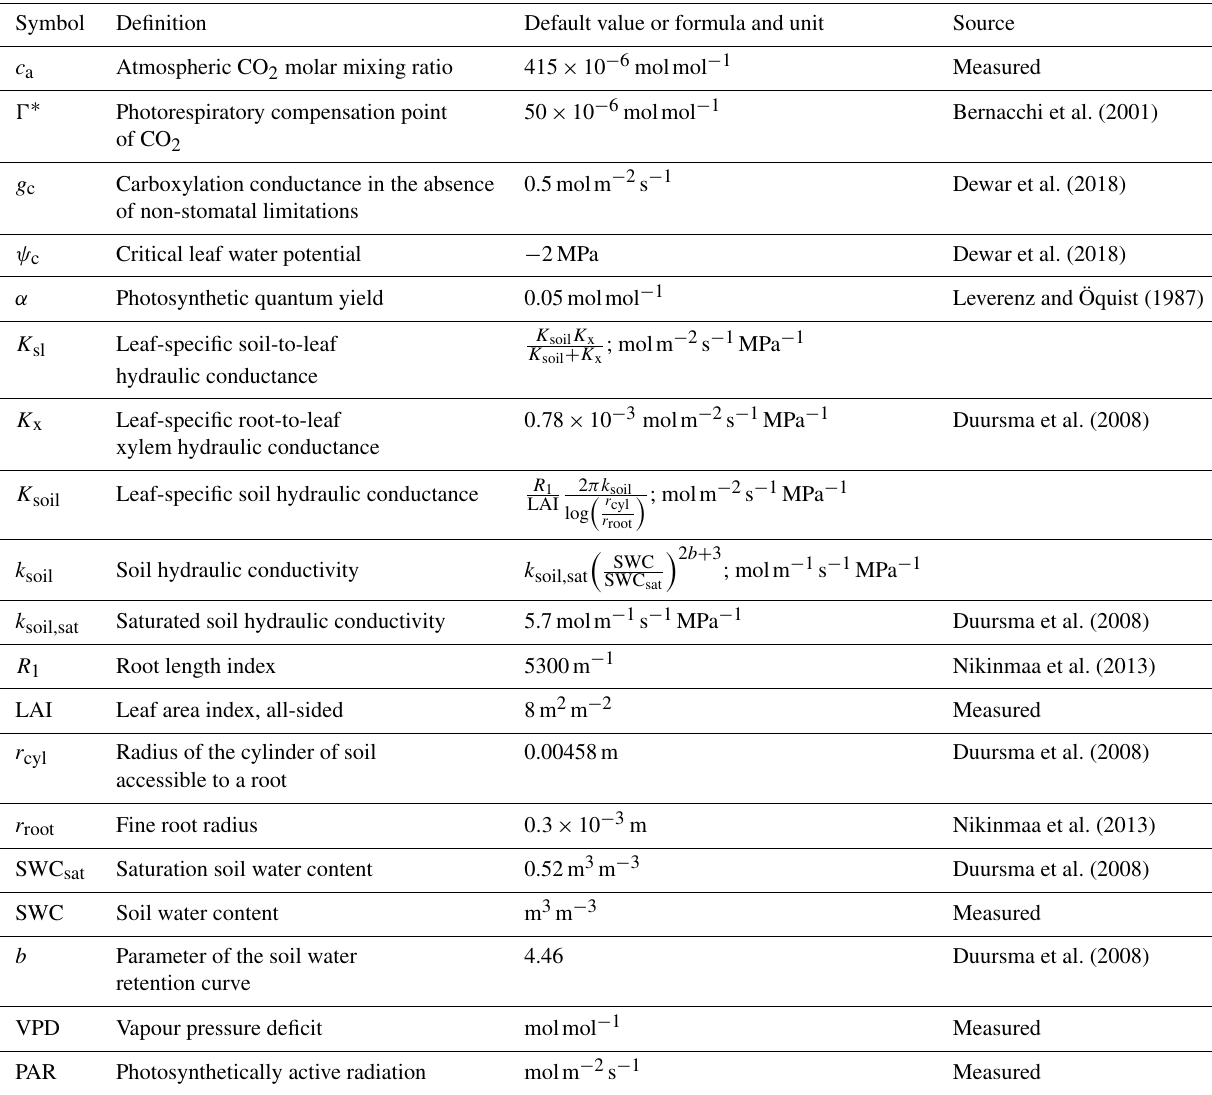
Table 1. Explanations, literature values, and sources of the parameters used in the LRU CAP formulation for Hyytiälä forest. c a was derived from the measurements in Kooijmans et al. (2019), and SWC, PAR, and VPD from measurements done in this study. Soil-related values ( K soil,sat , r cyl , SWC sat , and b ) are for soil horizon B (which was considered to be representative of the rooting zone), where the SWC measurements were also